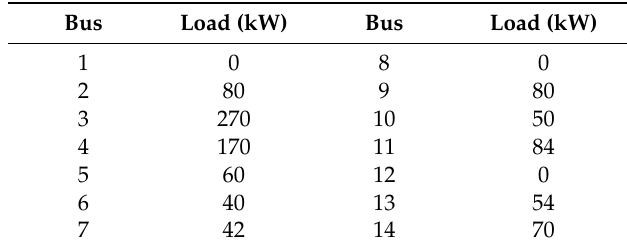
Table 3. Load data of a 14-node FREEDM microgrid.